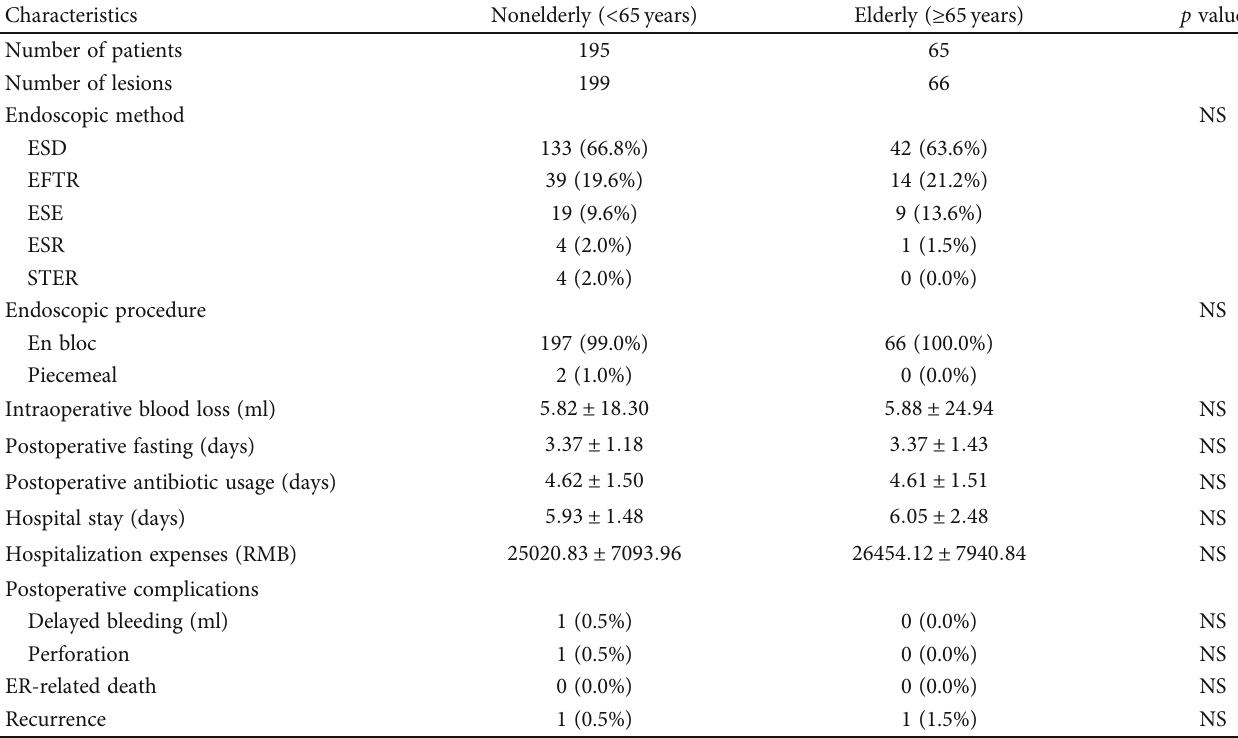
Table 3: Perioperative information and postoperative complications of